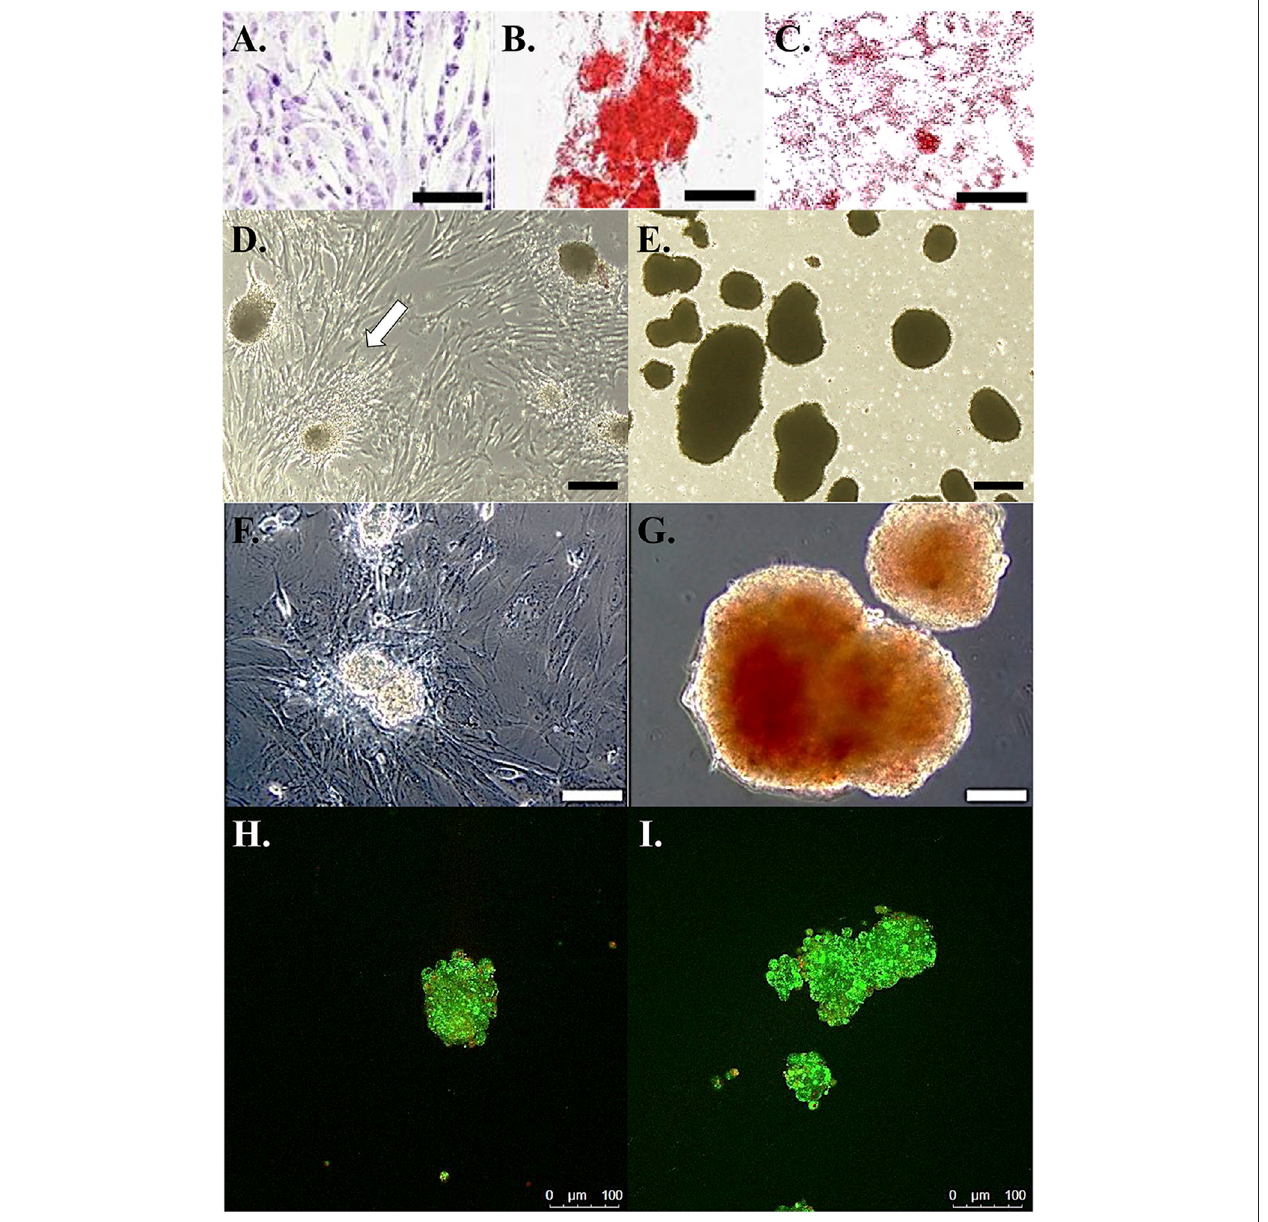
FIGURE 2 | Photomicrographs of feline ASCs following culture in stromal medium (A) , with calcium deposition alizarin red staining after culture in osteogenic medium (B) , and with oil red O lipid staining after culture in adipogenic medium (C) . Light photomicrographs of cell clusters from feline ASCs in polystyrene cultureware after 3-stage culture in stromal (D) or pancreatic induction (E) medium. Cells attached to the polystyrene surface are evident with clusters cultured in stromal medium (arrow). Dithizone stainingofzinc [red, (F,G) ]and viabilitystaining (H,I) ofviable(green)and non-viable(red) cellsinclustersfrom felineASCs after 3-stageculture in stromal (F,H) or pancreatic induction (G,I) medium. Scale bars = 200 μ m (A,D,E) , 50 μ m (B,C) , and 100 μ m (F – I) .